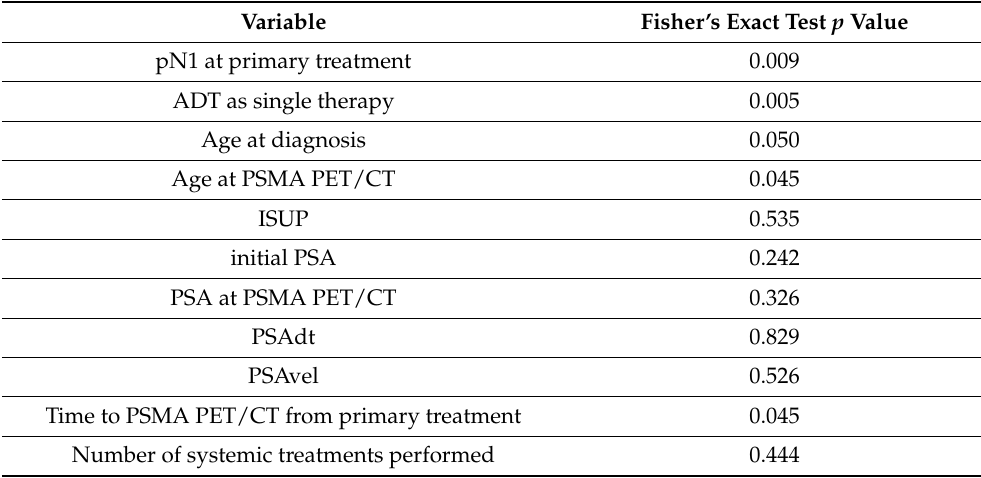
Table 4. Univariate analysis of the variables taken into